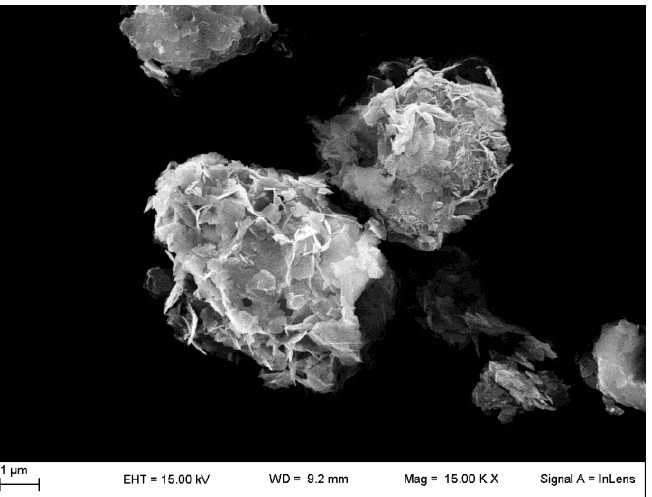
Figure 6. FE-SEM image of the FFC named Omyapharm 500 OG Omya, taken through a LEO 1525 ZEISS instrument (Jena, Germany). ZEISS instrument (Jena,